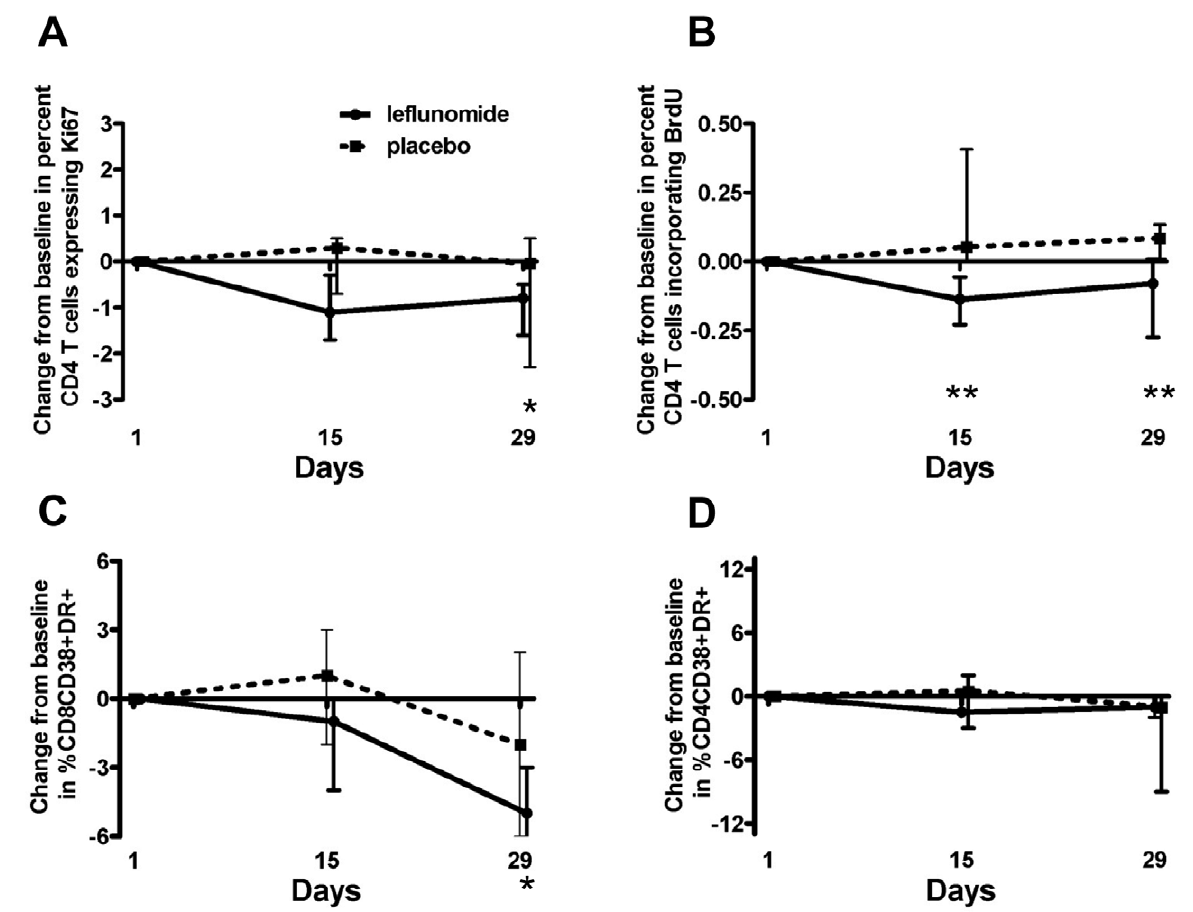
Figure 3. Changes in markers of CD4 T cell cycling and CD8 T cell activation. A) Change from baseline in percent Ki67 expression in CD4 T cells; median values and interquartile ranges. There was a significant decrease in Ki67 expression by CD4 T cells at Day 29 in the leflunomide group (*p-value , 0.05). B) Change from baseline in percent BrdU incorporation by CD4 T cells; median values and interquartile ranges. There was a significantly greater change in BrdU incorporation by CD4 T cells in the leflunomide group compared to the placebo group at Day 15 and Day 29 (**p-value , 0.05). C) Change from baseline in percent of activated CD8 T cells (%CD8CD38 + HLADR + ), median values and interquartile ranges. There was a significant decrease in activated CD8 T cells at Day 29 in the leflunomide group (*p-value , 0.05). D) Change from baseline in percent of CD4 T cells co-expressing CD38 and HLA-DR, median values and interquartile ranges.